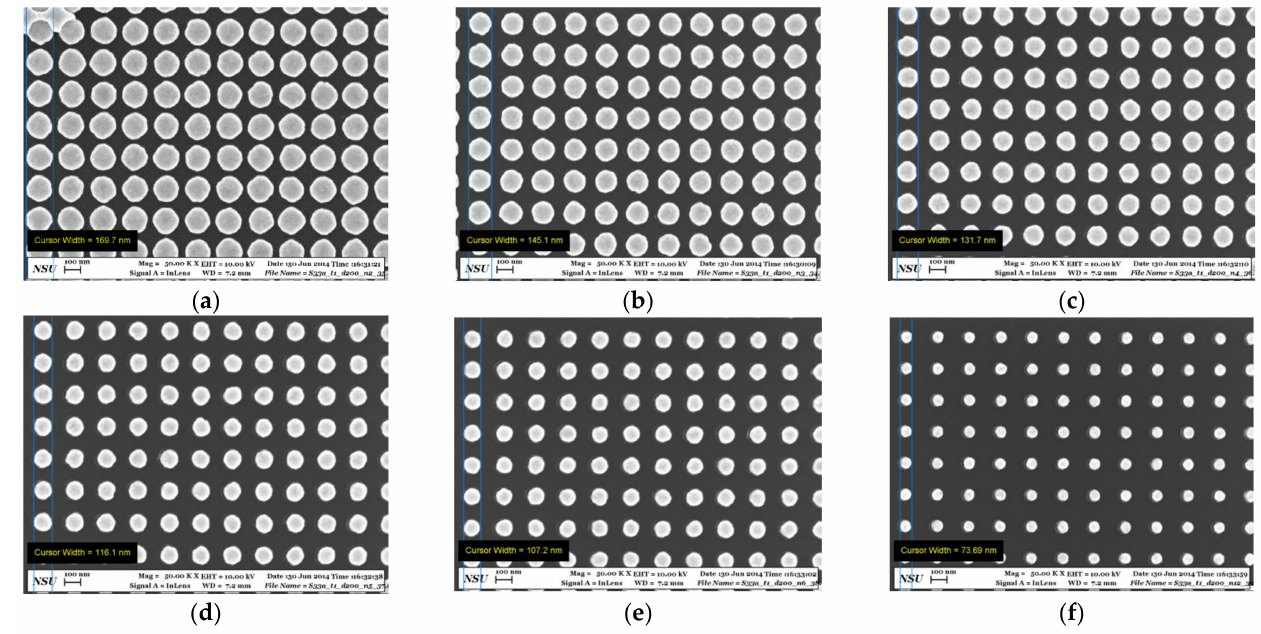
Figure 1. Representative high-resolution SEM images of Au nanocluster arrays with a period of 200 nm and various nanocluster diameters: ( a ) 170 nm, ( b ) 145 nm, ( c ) 132 nm, ( d ) 116 nm, ( e ) 107 nm, and ( f ) 74